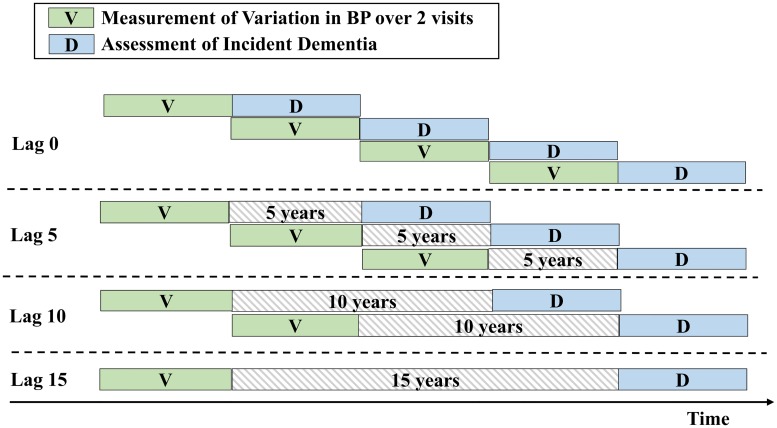
Schematic diagram of the analyses relating BP variation to the risk of dementia at different lag periods.aThe years of lag indicate the minimum interval between the measurement of BP variation and the assessment of incident dementia. A lag of 0 examined the risk of dementia during the visit interval immediately following the measurement of BP variation. A lag of 5 years investigated the risk of dementia occurring at least 5 years after the measurement of BP variation, in which dementia cases occurring within the first 5 years of follow-up were censored, and so on. BP, blood pressure.